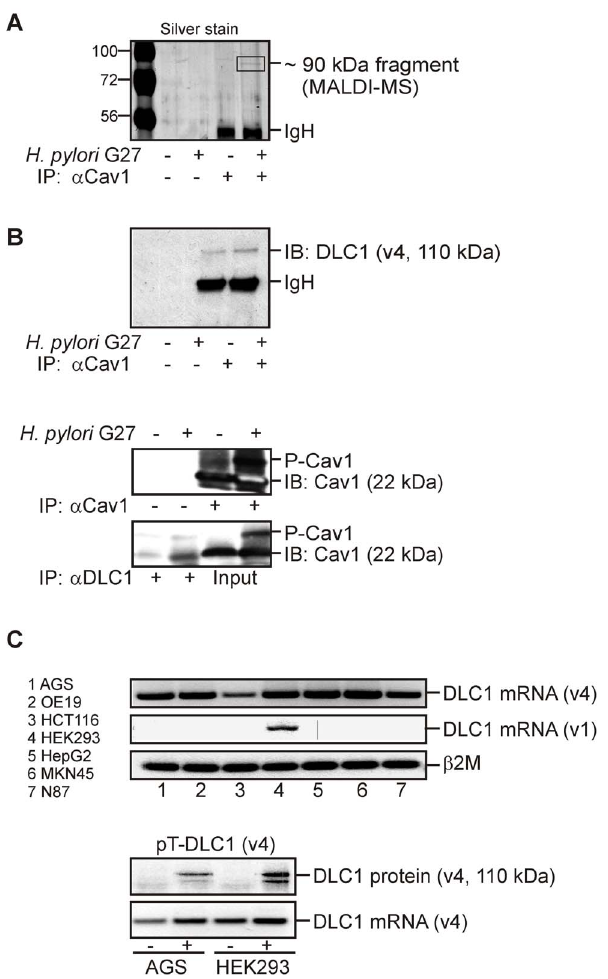
Figure 7. Cav1 binds p120RhoGAP/DLC1 upon infection of human GC cells with H. pylori G27. (A) Cav1 interacts with p120RhoGAP/DLC1, a tumor suppressor and inhibitor of small GTPases associated with focal adhesions and caveolae/lipid rafts. AGS/Cav1 cells were infected with CagA-delivery competent H. pylori G27 (MOI=100) for 16 h. Total cell lysates were subjected to CoIP with rabbit polyclonal Cav1-antiserum. Gels were silver stained, and peptides within a band ( , 95 kDa) enriched in infected cells were analysed by MALDI-MS (see also Table S2 ). (B) Validation of MALDI-MS. Cells were infected as (A), and total cell lysates were subjected to CoIP using antibodies against Cav1 and DLC1, respectively. Representative WBs show the , 110 kDa DLC1 protein variant 4 (DLC1v4). (C) DLC1 mRNA and protein expression. Top panel: RT-PCR gels detecting DLC1 mRNA variant 1 (full length according to [39]) in HEK293 cells, whereas DLC1v4 (short form according to [39]) was expressed in all human cancer cell lines tested. Bottom panel: Cells were transiently transfected with the expression vector pTarget-DLC1v4 (pT-DLC1v4). Representative RT-PCR and WB gels visualizing the transfected DLC1v4 mRNA and the , 110 kDa DLC1v4 protein are shown.